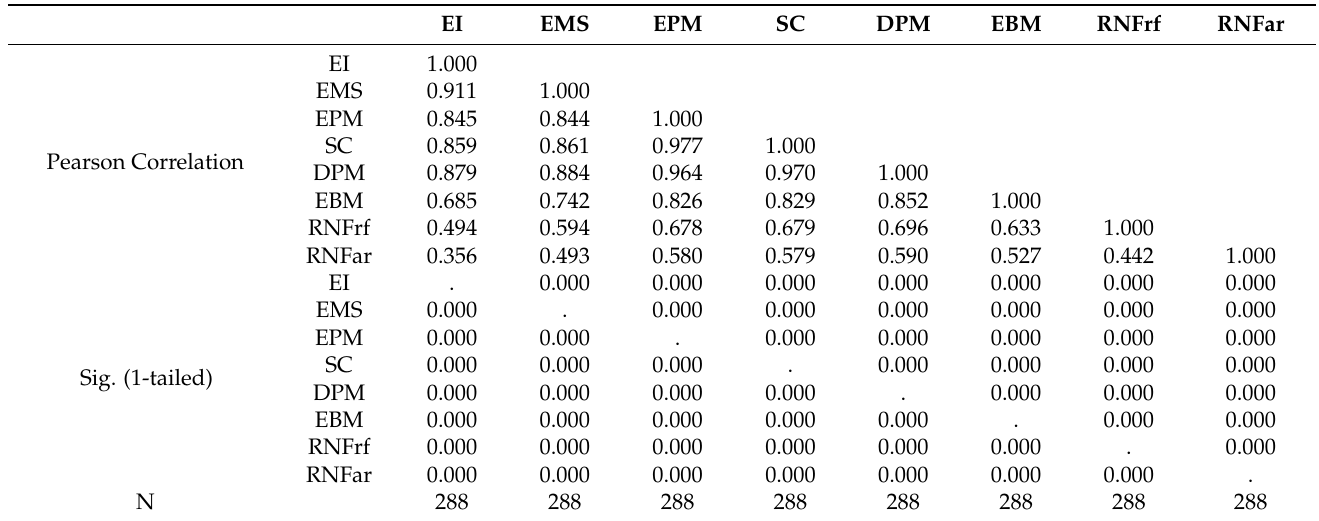
Table 11. Person Correlation.